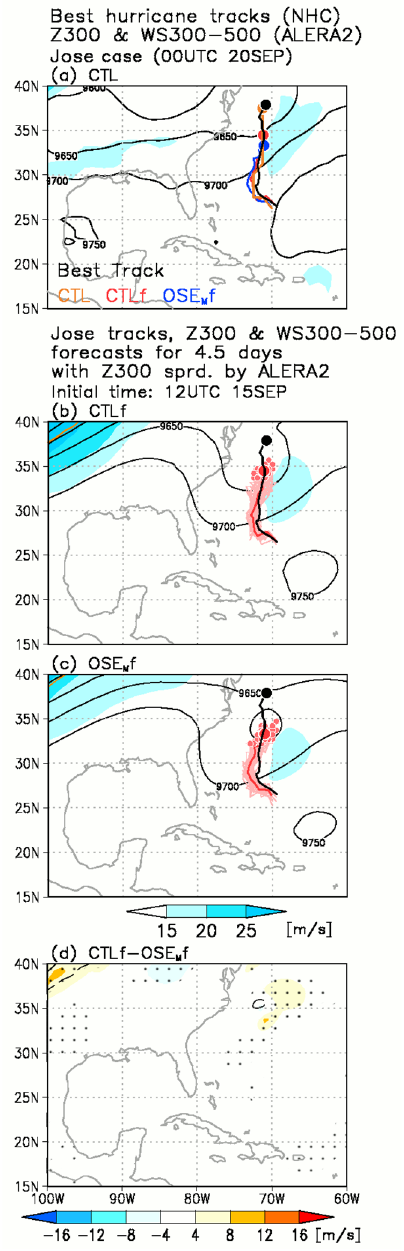
Figure 7. ( a ) Upper-level wind speed (averaged between 300- and 500-hPa levels; shaded; unit: m · s − 1 ) and geopotential height at 300 hPa (Z300; contour; unit: m) at 0000 UTC 20 September 2017 in CTL; lines are tracks of Jose between 1200 UTC 15 September 2017 and 0000 UTC 20 September 2017 from the National Hurricane Center (NHC) best track data (black) and CTL (orange), and predicted ensemble mean tracks from CTLf (red) and OSE M f (blue) between 1200 UTC 15 September 2017 and 0000 UTC 20 September 2017. ( b – d ) Predicted ensemble mean upper-level wind speed (averaged between 300- and 500-hPa levels; shaded; unit: m · s − 1 ), Z300 (black contour; unit: m), Z300 ensemble spread (orange contour; unit: m), and predicted tracks of Jose between 1200 UTC 15 September 2017 and 0000 UTC 12 September 2017 with ensemble mean (thick line) and ensemble members (thin lines) from ( b ) CTLf and ( c ) OSE M f; black line is track of Jose from NHC best track data. ( d ) Di ff erence between CTLf and OSE M f in ensemble mean upper-level wind speed (averaged between 300- and 500-hPa levels; shaded; unit: m · s − 1 ), Z300 (black contour; unit: m) and Z300 ensemble spread (orange contour; unit: m); dots indicate statistical significance at 99% confidence